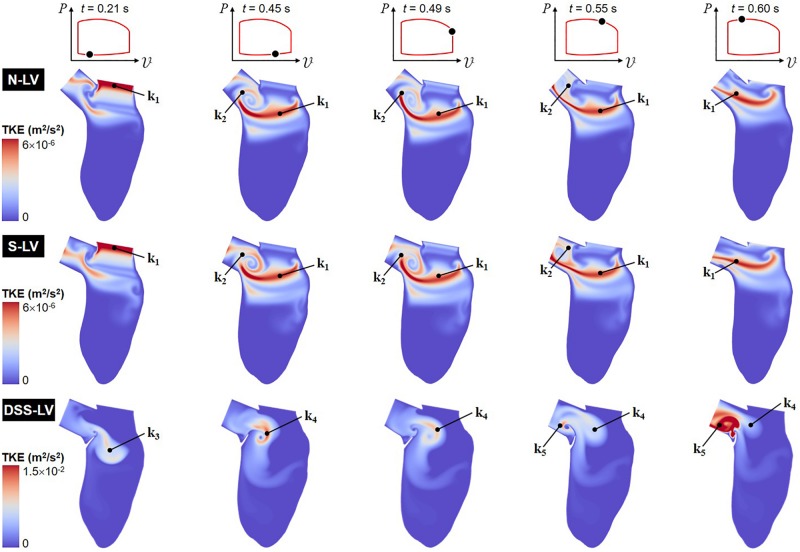
Snapshots of the TKE contour fields captured in the N-LV, S-LV and DSS-LV models during early ventricular filling (0.21 s), late filling (0.45 s), early systole (0.49 s), acceleration phase (0.55 s), and at peak systole (0.60 s).